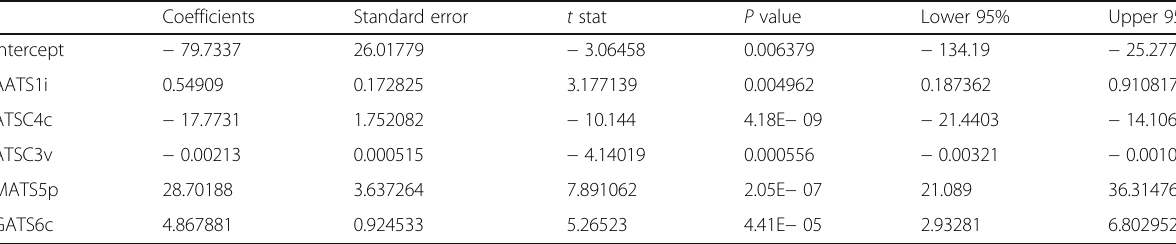
Table 7 Regression statistics of the descriptors in model